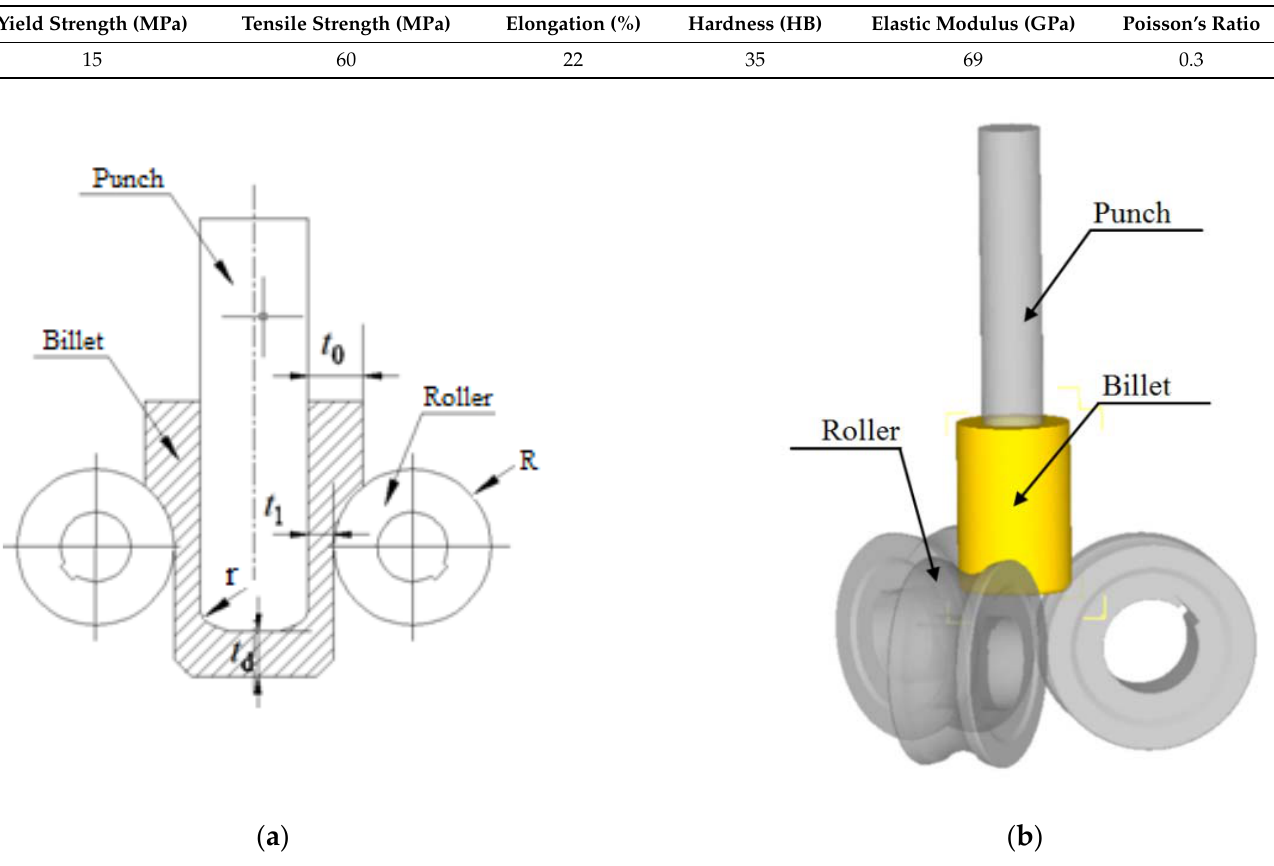
Table 1. Physical and mechanical properties of pure aluminum 1060.